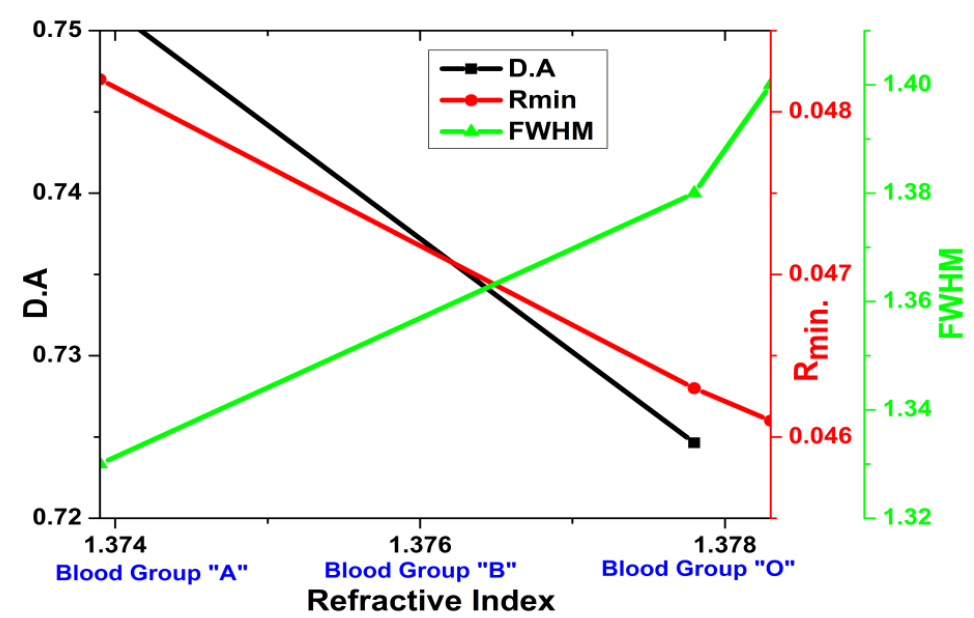
Figure 5. Minimum Reflectance, FWHM and DA of proposed SPR sensor with respect to RI of Blood group samples “A”, “O” and “B”.